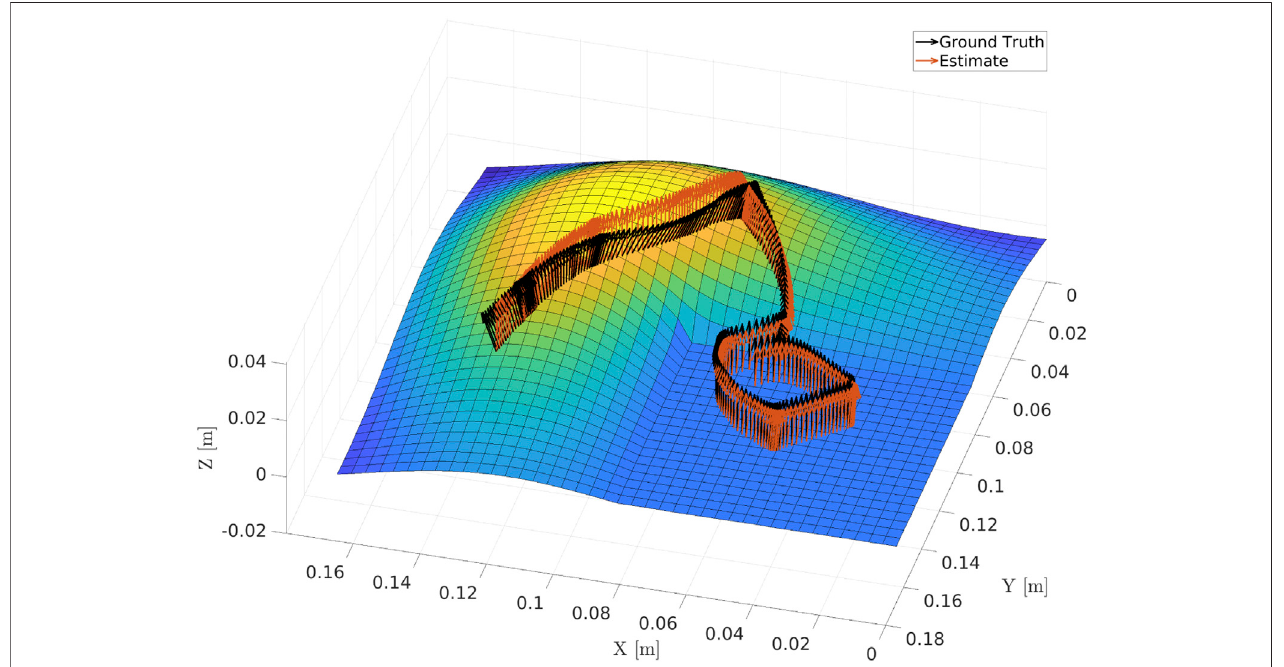
FIGURE 9 | Estimation error for the surface normal compared to the ground truth.